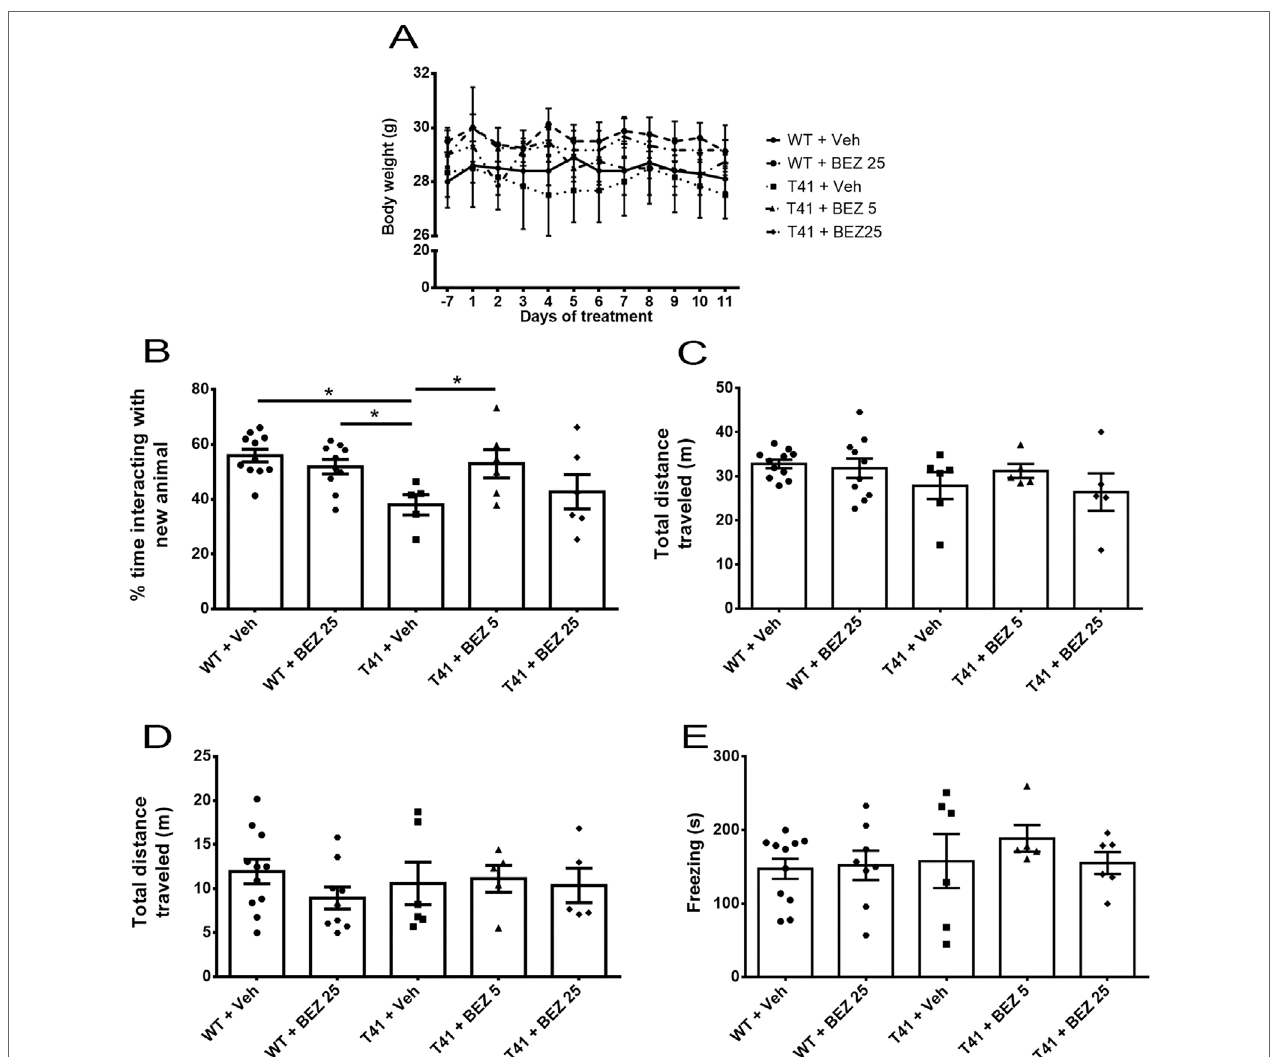
fIGURE 1 | Effects of BEZ treatment on mice weight, memory, and locomotor activity. (A) Lines represent the quantification of BEZ treatment effect on animal’s weight; (B) Bar graphs represent the quantification of BEZ treatment effect on animal’s social memory; (C) Total traveled distance during the social memory test; (D) Total traveled distance in open field test; and (E) freezing time in the contextual conditioned fear test. WT + Vehicle (n = 11), WT + BEZ 25 (n = 10), T41 + vehicle (n = 6), T41 + BEZ 5 (n = 6) and T41 + BEZ 25 (n = 6). *p < 0.05 (ANOVA followed by Newman-Keuls test).